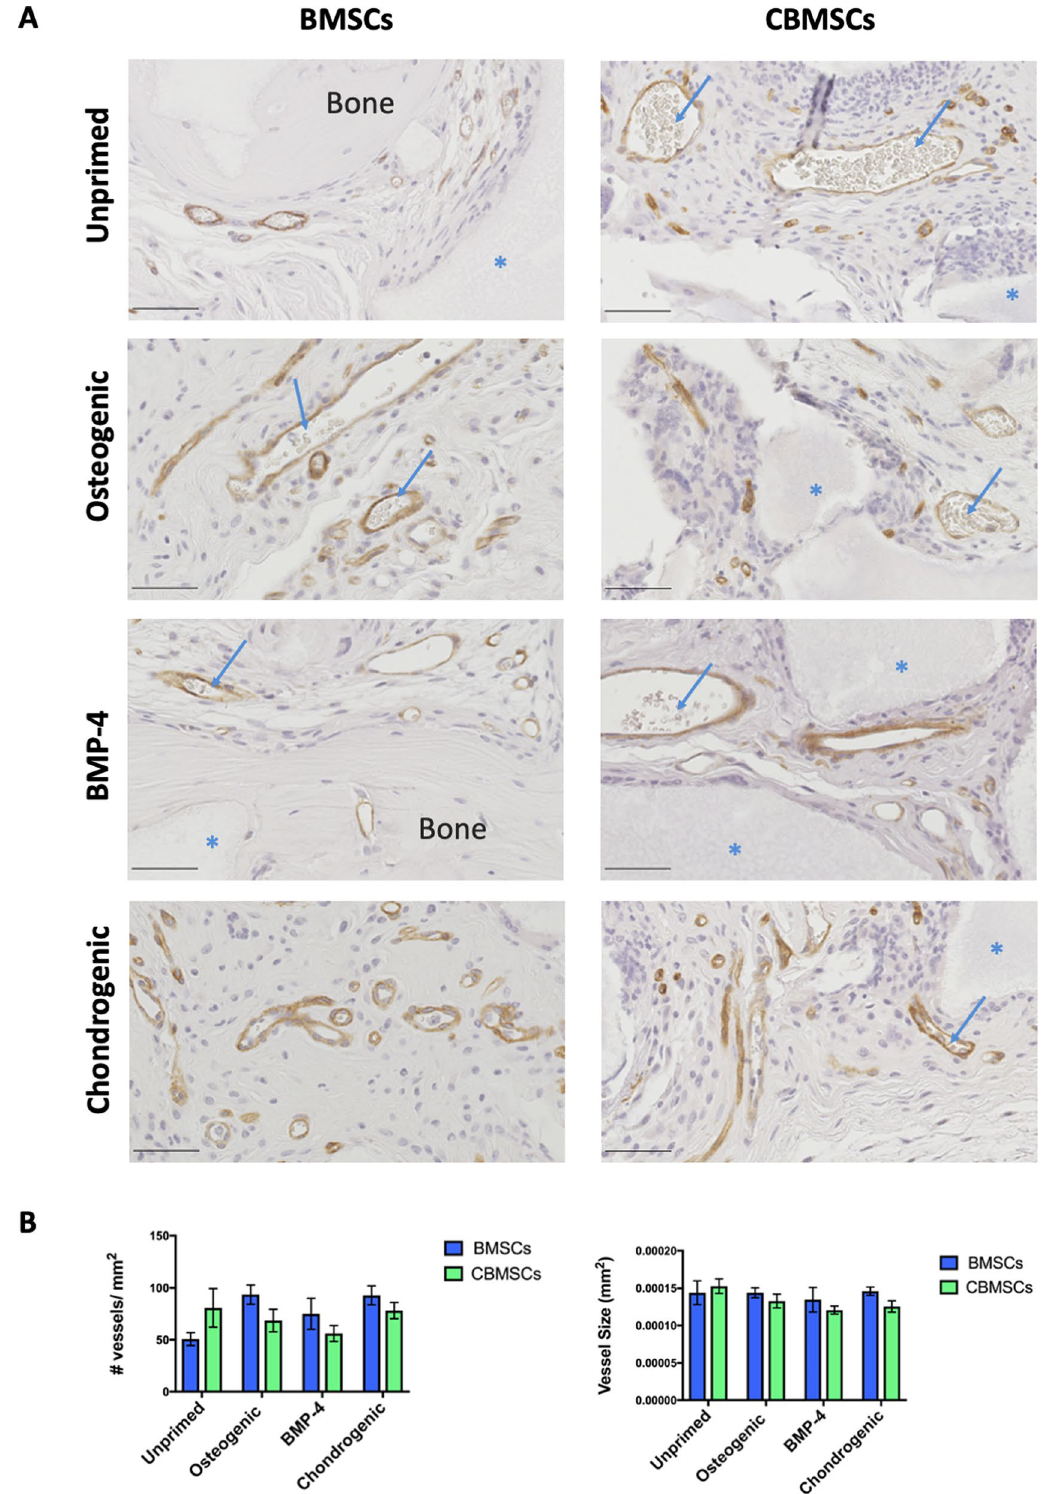
Figure 6. CD146 immunostaining for neovascularization. ( A ) Blood vessels are shown in brown with erythrocytes inside the blood vessels highlighted by the blue arrows, newly formed bone tissue is indicated and BCP biomaterials are shown in grey as indicated by the blue asterisks. Scale bars represent 50 μm. ( B ) Quantification of the number of blood vessels per mm 2 , and the size of newly formed blood vessels of BMSC and CBMSC groups ± priming. Data are presented as mean ± SEM. Statistical analysis was by two-way ANOVA followed by Holm–Sidak’s multiple comparison